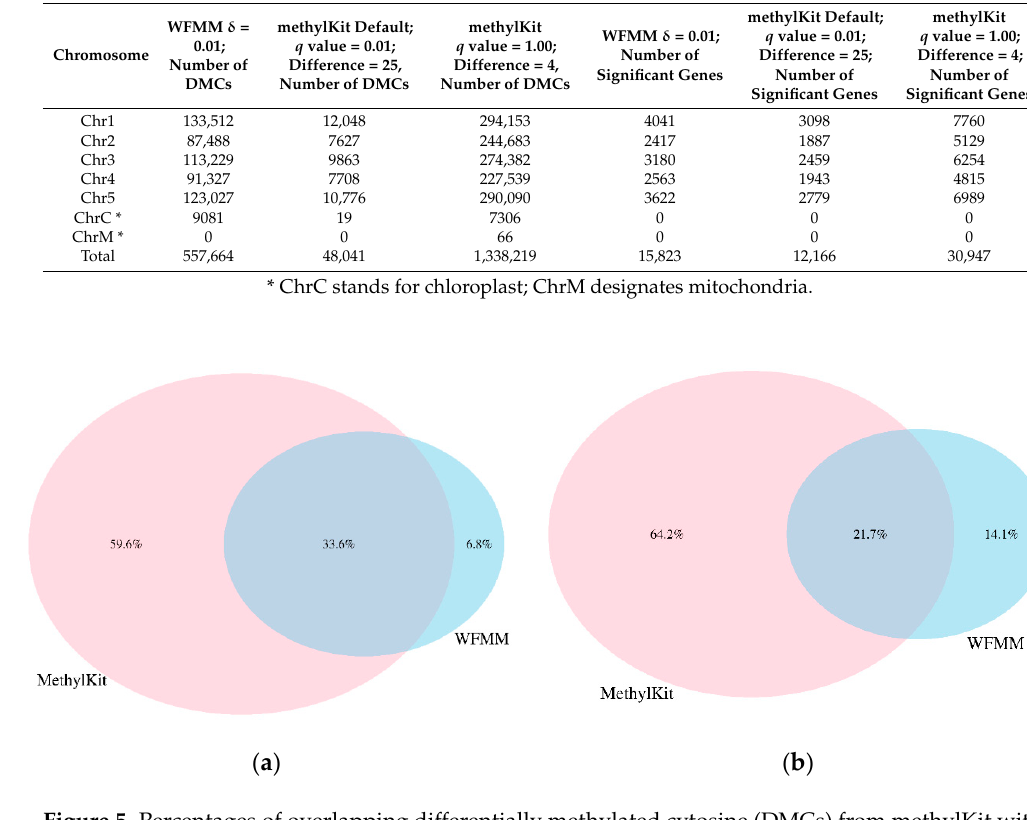
methylKit with default settings has 39 genes, while methylKit with relaxed settings (difference = 4; (Table 2). Though there are minor differences in gene clusters between methylKit and WFMM with δ = 0.01, the GO analysis results from the two methods are very similar (Figures 6 and